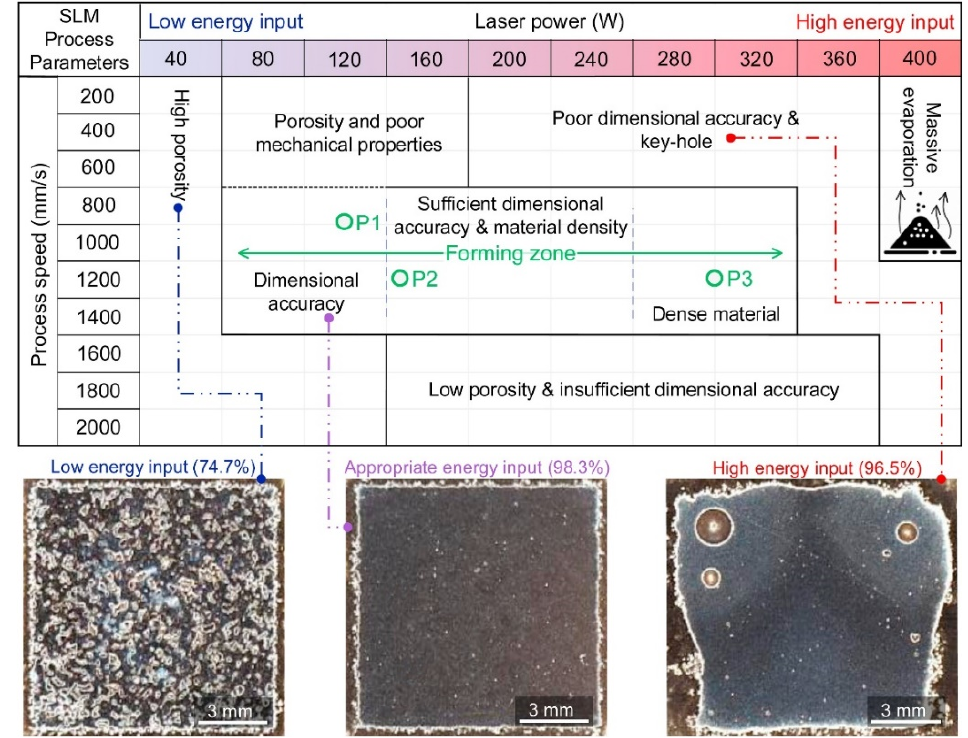
Figure 3. Effect of SLM process parameters on the formability of WE43. Reprinted with permission from ref. [40]. Copyright 2020 Elsevier.